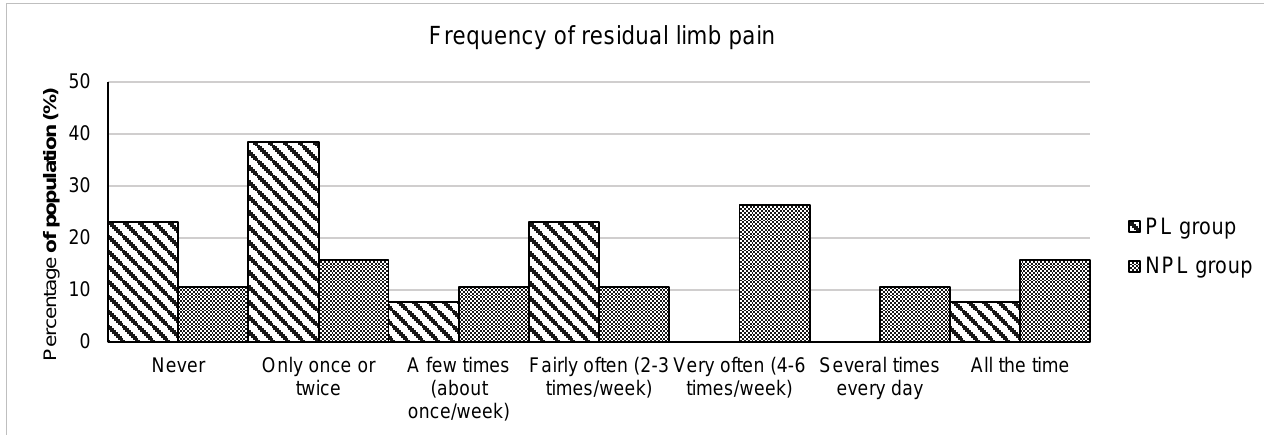
Figure 2: Residual limb health PEQ subset score for the NPL control group (grey) and the PL group (green). The error bars indicate ± one standard deviation from the mean. Asterisks (*) indicate a statistically significant change (p<0.05).